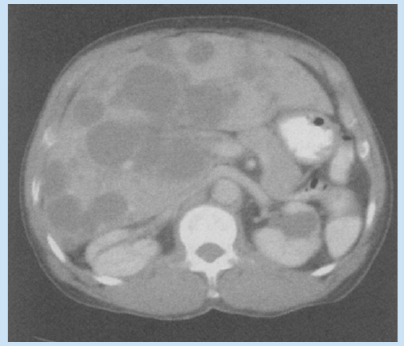
Fig. 2b. Helical computerised tomography post IV contrast confirming hepatic and cortical cysts.